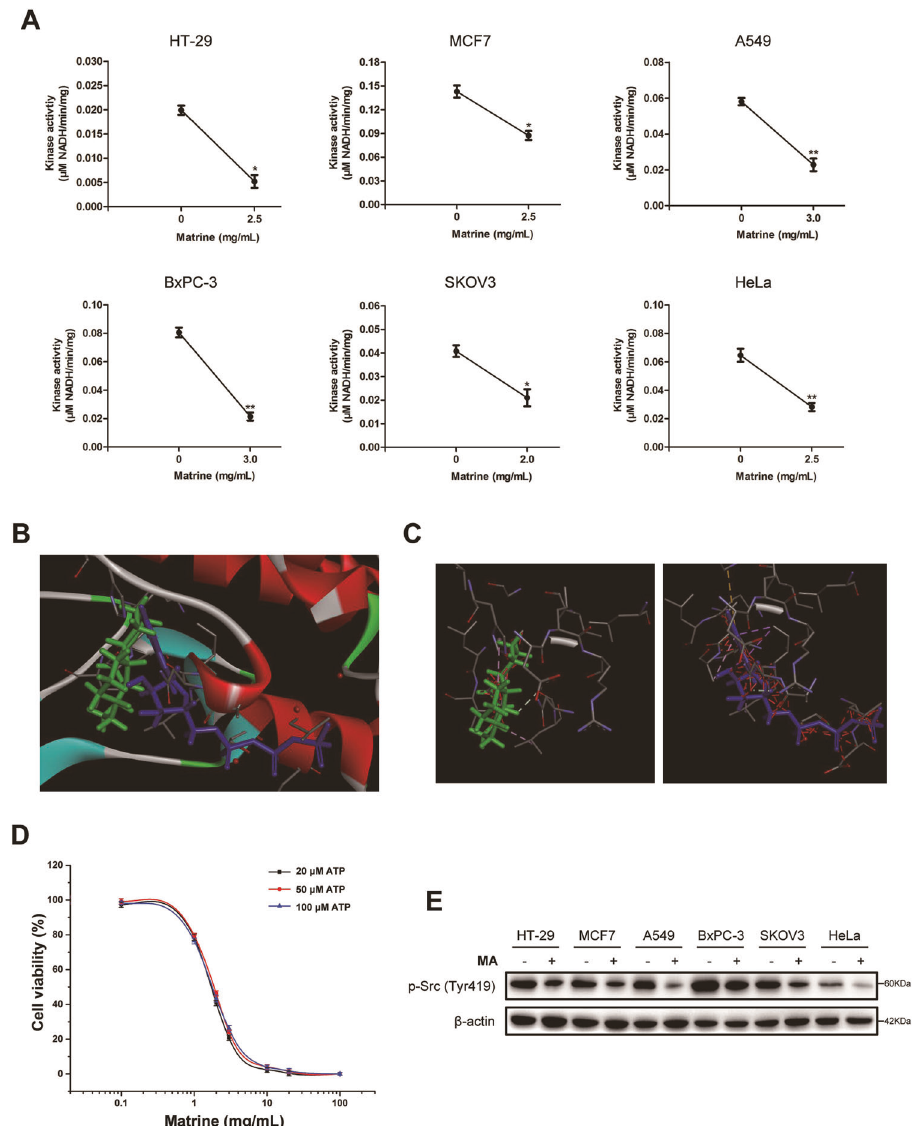
Fig. 4 Matrine was a non-ATP-competitive inhibitor of Src kinase. A The effect of matrine on Src kinase activity in cancer cells, including HT- 29, MCF7, A549, BxPC-3, SKOV3, and HeLa, were determined according to the instructions of Src kinase activity detection kit. Results are representative of three experiments (* P < 0.05, ** P < 0.01). B , C Schematic diagram of matrine and ATP bound to Src kinase domain. Matrine (green) and ATP (bule) molecules were depicted as the ball-and-stick models. D Dose – response curves of matrine against Src kinase at various ATP concentrations. Data are the mean ± SD of three independent experiments. E HT-29, MCF7, A549, BxPC-3, SKOV3, and HeLa cells were exposed to matrine at its optimal concentrations for 24 h, respectively. The effects of matrine on the p-Src (Tyr419) were analyzed by western blot, respectively. β -Actin was used as a